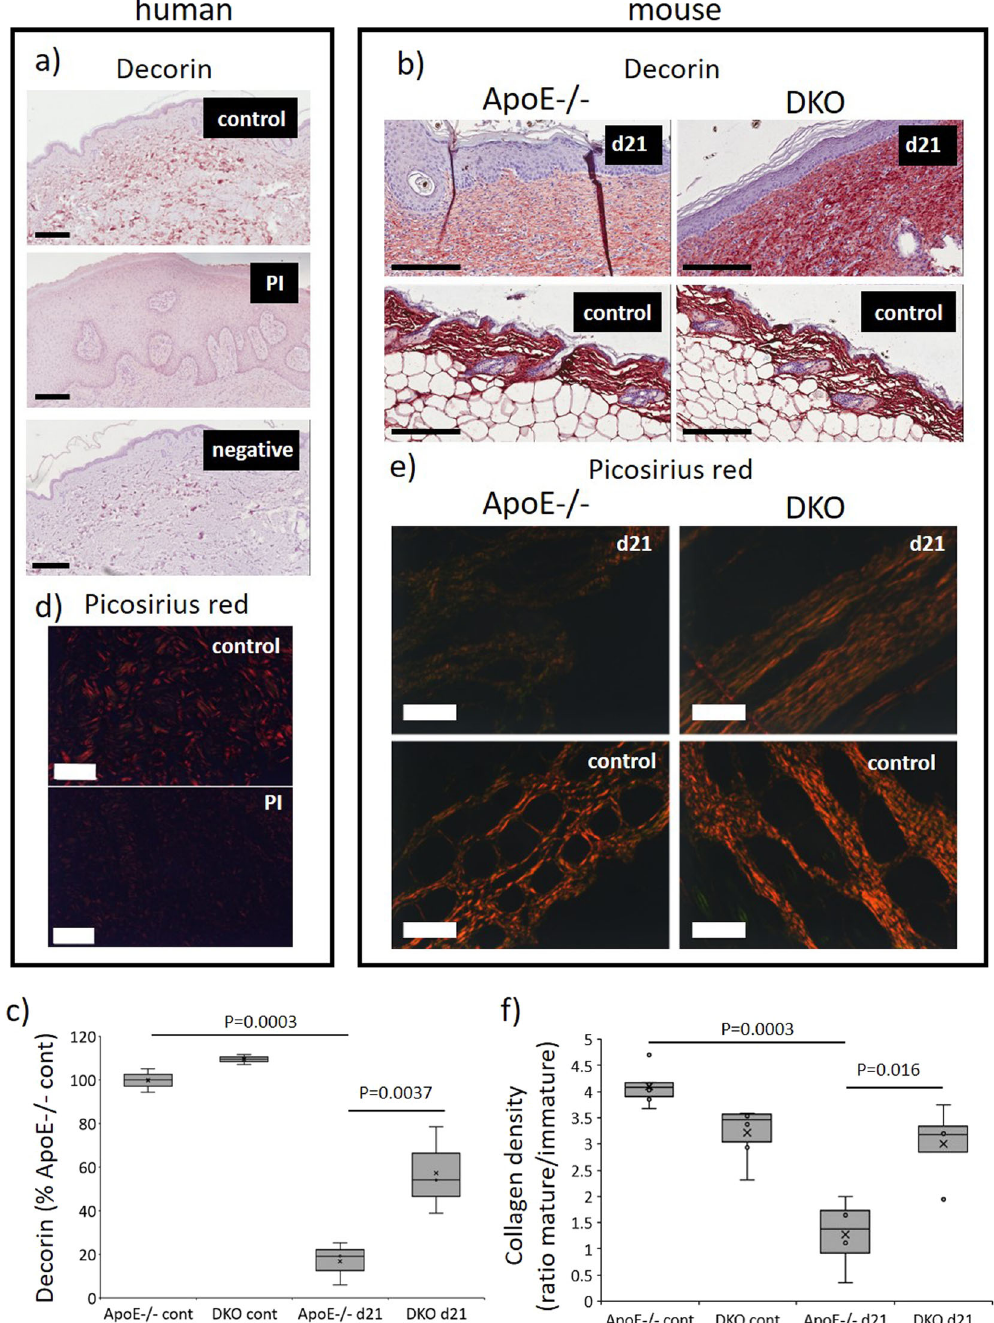
Fig. 5 Reduced decorin intensity and improved collagen maturation in DKO mice PI. Representative images of decorin immunohistochem- istry ( a ) and Picosirius red ( d ) in mouse PI at d21 post-initiation of I/R. Scale bar = 300µm ( a ) and 200 µm ( d ). Quanti fi cation of decorin ( c ) and Picosirius red ( f ). Data in c , f analyzed by two-way ANOVA with Bonferonni post-test and presented as c intensity per unit area as the percentage of ApoE − / − control and f the ratio of mature (red) to immature (green) collagen, n = 4 samples per group. Representative images of decorin immunohistochemistry ( b ) and Picosirius red ( e ) in human PI and unwounded control skin. Scale bar = 200 µm ( b , e